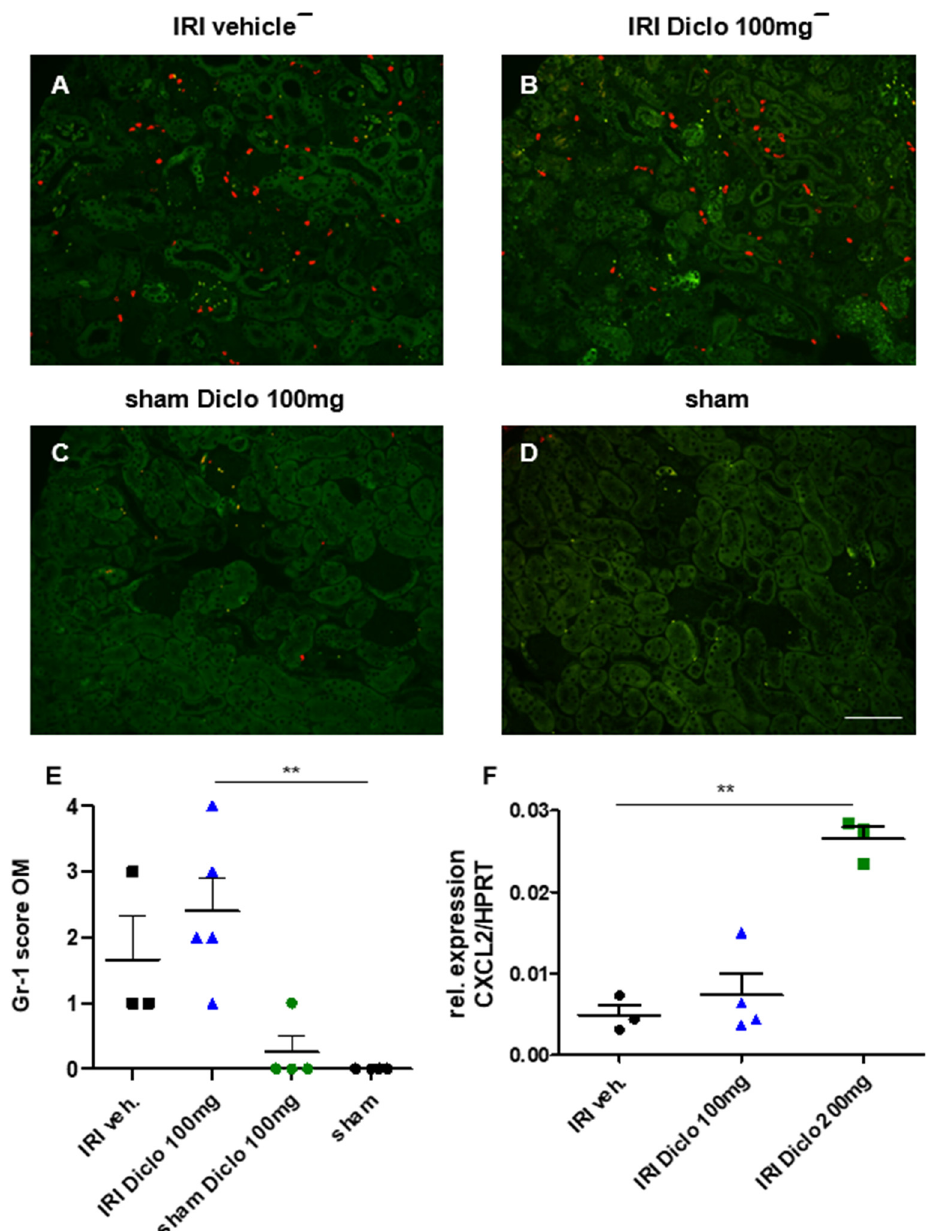
Figure 4. Renal neutrophil infiltration three days after renal ischemia–reperfusion injury (IRI) and repetitive diclofenac treatment and CXCL2 expression after a single oral dose of diclofenac. Gr-1 stain for neutrophils was performed on kidney sections of IRI mice treated with vehicle ( A ), or repetitive doses of 100 mg diclofenac ( B ) over three days are shown. Sham-operated mice treated with 100 mg diclofenac over three days ( C ) and vehicle-treated sham mice ( D ) served as control. Semi-quantitative scoring of renal neutrophil infiltration is shown in E. Repetitive doses of diclofenac after IRI significantly increased renal neutrophil infiltration. Diclofenac treatment in the setting of sham surgery did not cause significant neutrophil infiltration compared with sham surgery with vehicle treatment ( E ). In line, CXCL2, the chemoattractant for neutrophils, is upregulated in the kidney tissue in subclinical AKI and single-dose diclofenac treatment in a dose-dependent manner (F). n = 4–5 mice in each group are shown. ** p < 0.01. Scale bar 100 μ m.